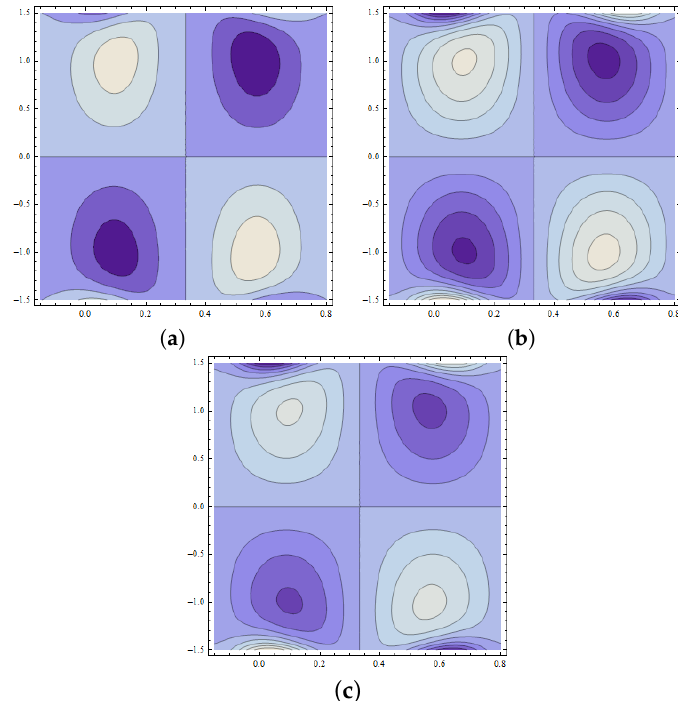
Figure 22. Pattern of streamlines when (cid:101) = 0.1, t = 0.1, m = 0.04, n = 0.4, E 1 = 0.2, E 2 = 0.2, E 3 = 0.3 and We = 0.4 with ( a ) m 1 = 1, ( b ) m 1 = 1.7, ( c ) m 1 = 2.